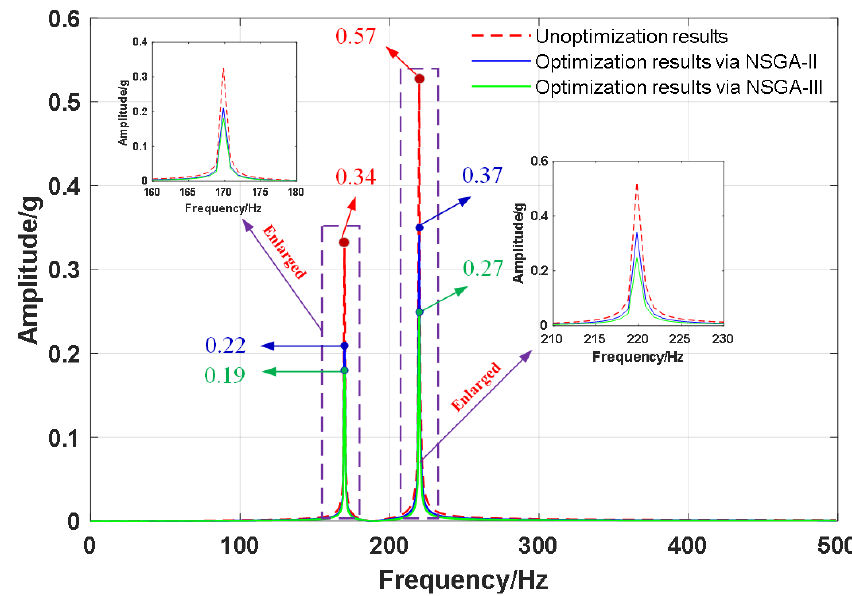
Figure 9. Vibration response of optimization results.